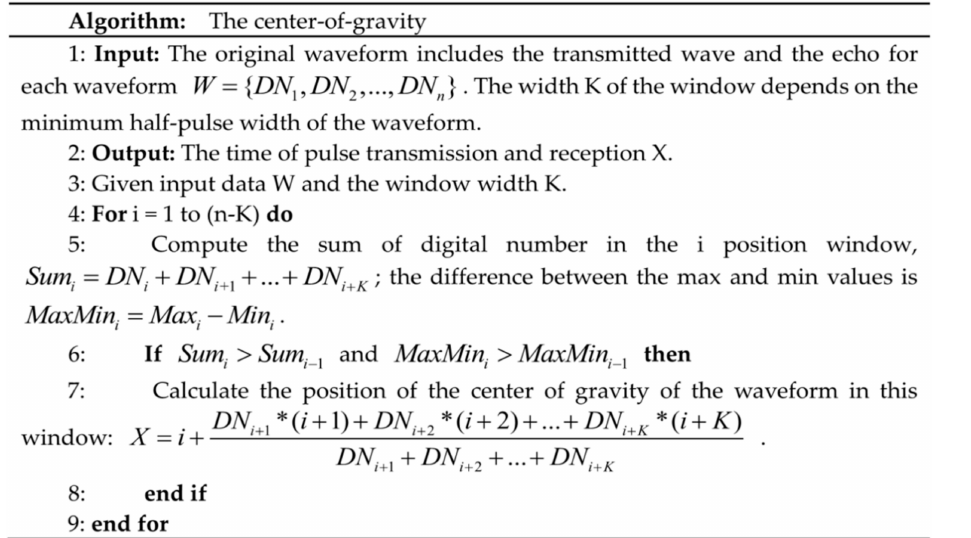
Figure 4. The COG